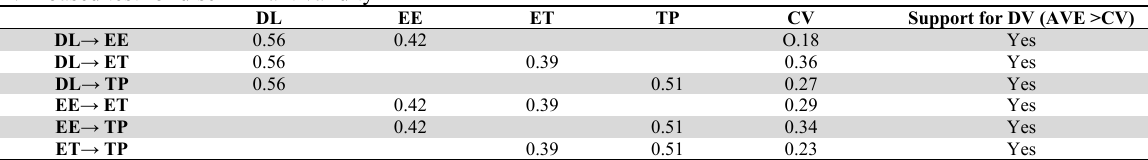
AVE-based test for discriminant validity